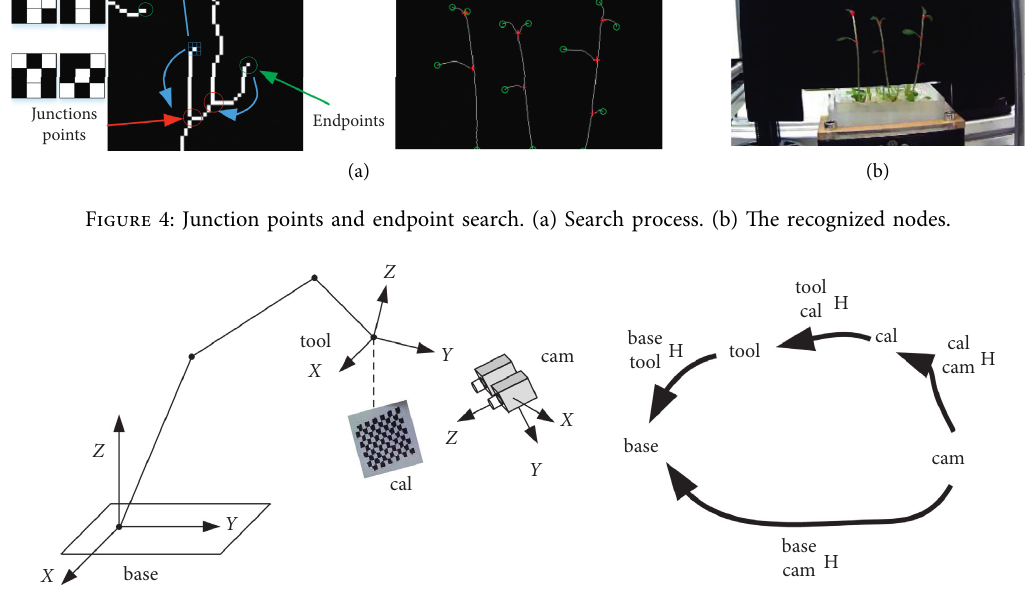
Figure 5: Hand-eye relationship